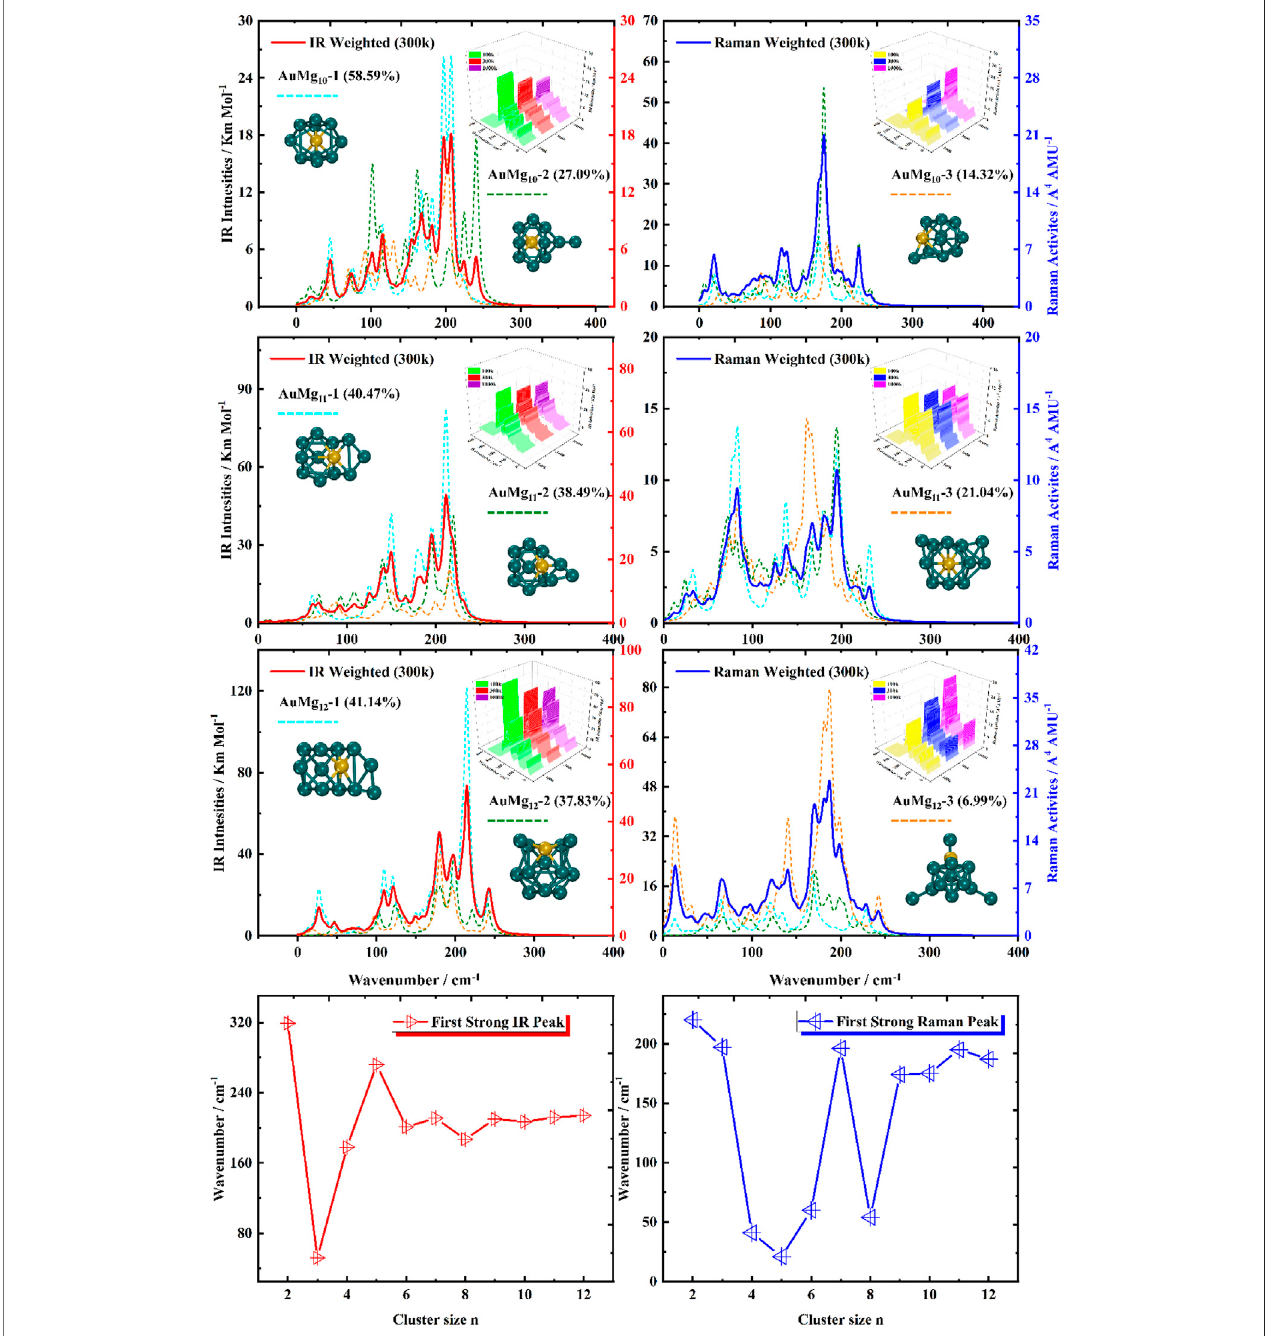
FIGURE9| BoltzmanndistributionweightedaveragespectraofthethreelowestenergyisomersofAuMg n ( n =10 – 12)nanoclustersatroomtemperature(IRonthe left side, Raman on the right side), and the fi rst strong IR and Raman peaks in AuMg n ( n = 2 – 12) nanoclusters.